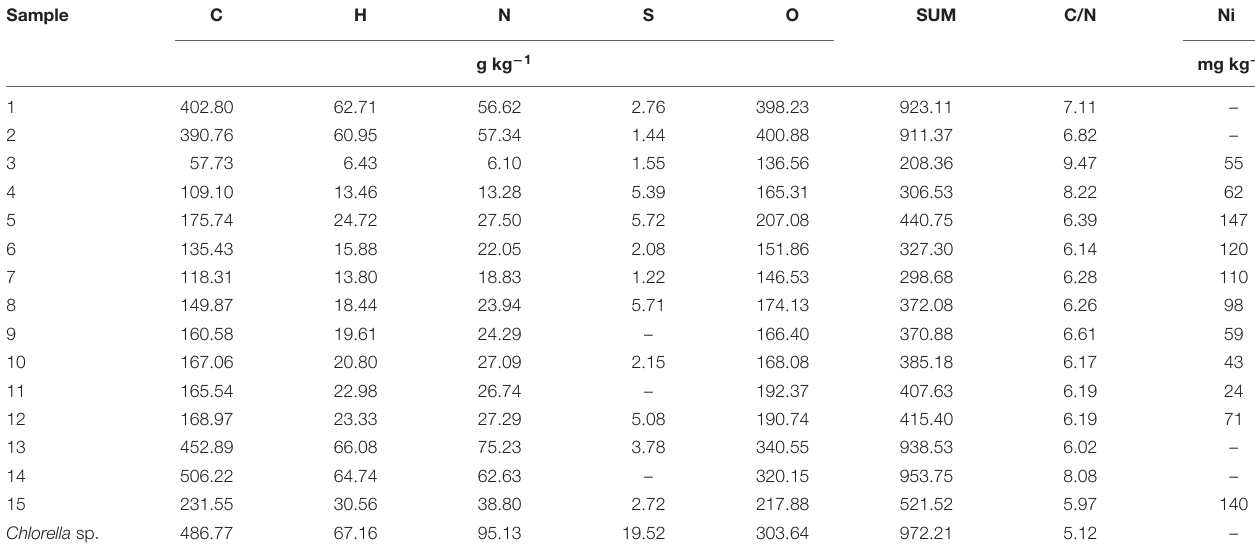
TABLE 3 | Organic elemental composition (CHNSO) of biomass samples and solid substrate together with contents of adsorbed Ni. Sample